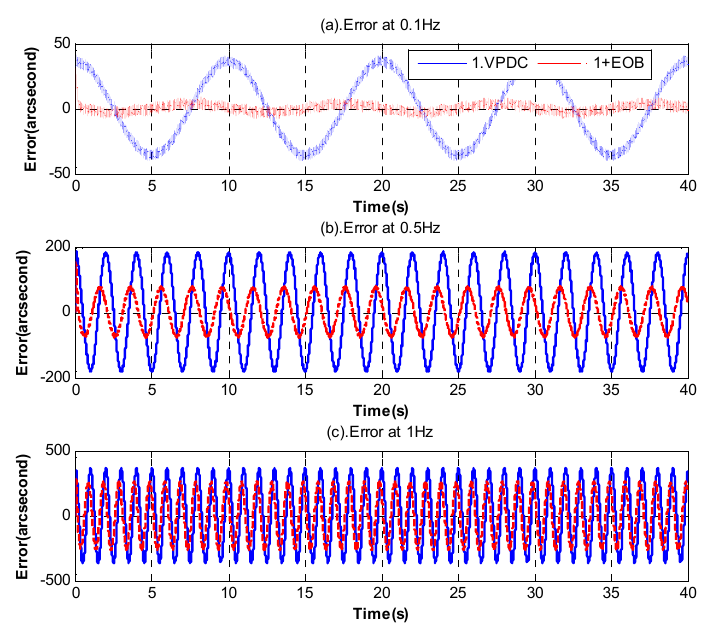
Figure 14. The residual tracking errors in different frequencies.